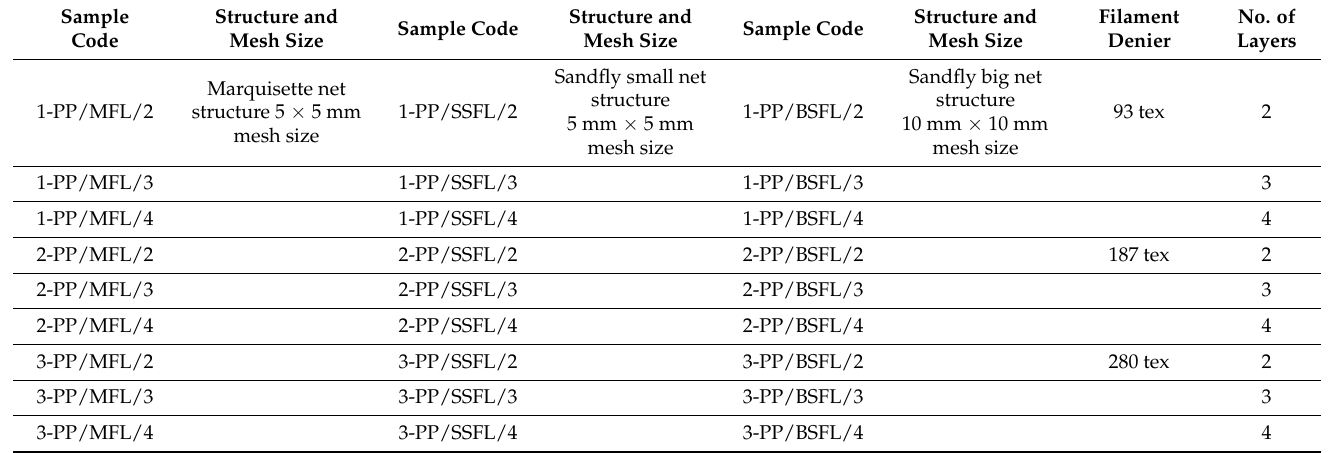
Table 4. Details of the 27 Ferrocement laminate samples.